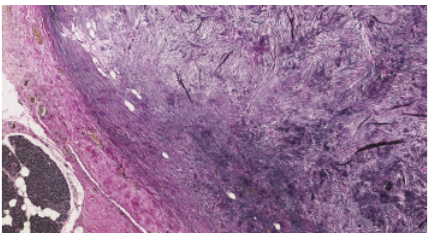
Figure 3: Each lesion was richly invested by bundles of elastic fibers (VVG,